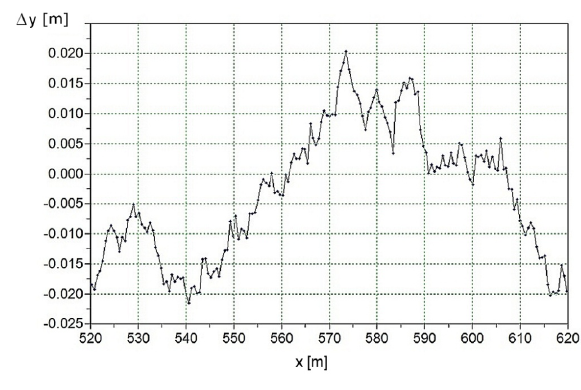
Figure 15: Matching of the circular arc. Radius R = 1000 m; adopted bounds of the measurement points: G L = 520 m and G R = 620 m.